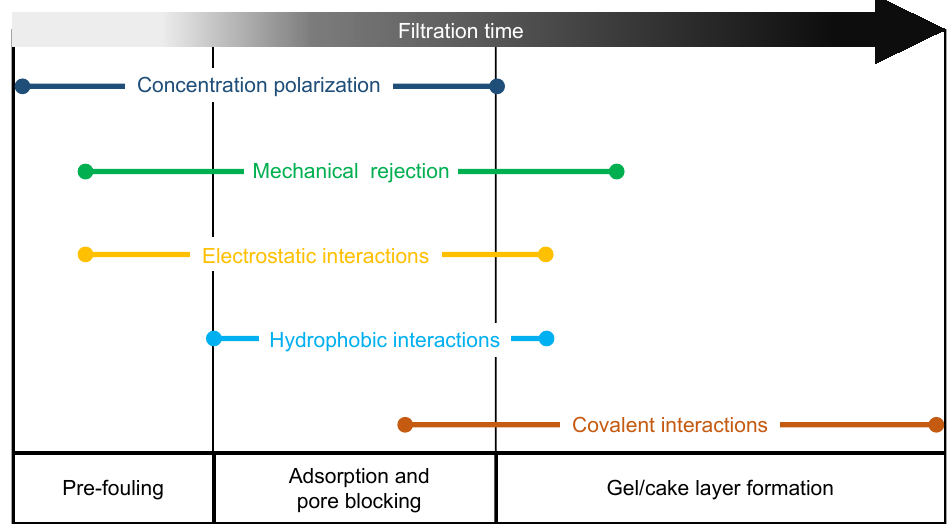
Figure 2. Principal foulant–foulant and foulant–membrane interactions involved in the three stages of fouling.